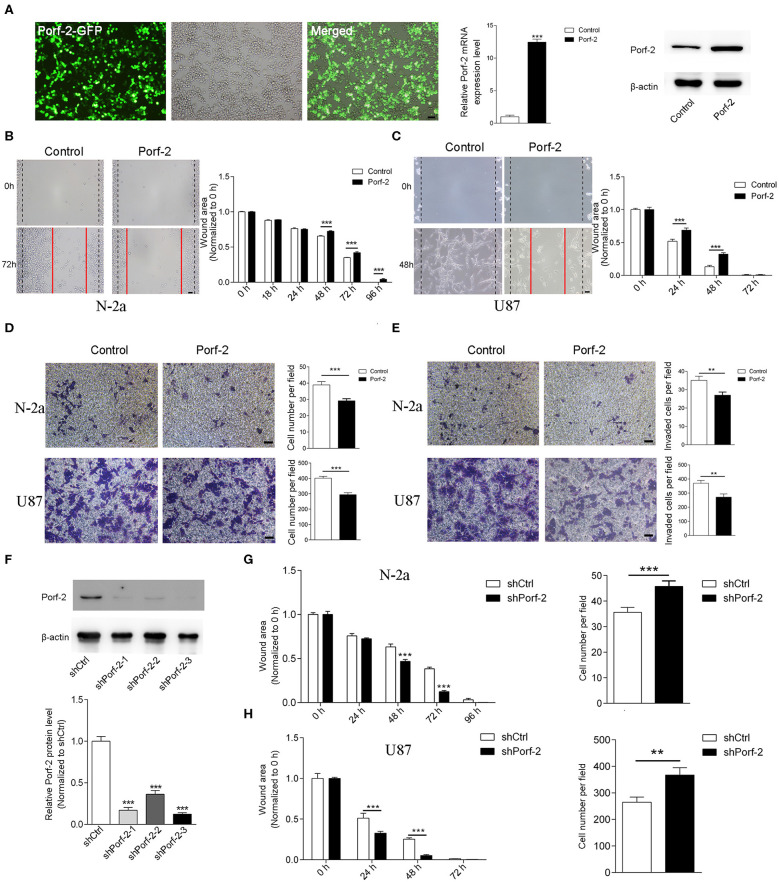
Porf-2 suppressed Neuro-2a cell migration. (A) The GFP image shows the overexpression of Porf-2 in N-2a cells. RT-PCR and western blotting confirmed the overexpression of Porf-2. β-actin was used as a loading control. Scale bar, 200 μm. (B) Representative images of the wound healing assay of N-2a cells at different time points in the control and Porf-2 group. The red lines indicate the wound area. Scale bar, 200 μm. Quantification of the wound area at the indicated time points in the control and Porf-2 group. (C) Representative images of the wound healing assay of U87 cells at different time points in the control and Porf-2 group. The red lines indicate the wound area. Scale bar, 200 μm. (D) Representative images of the N-2a and U87 cells that migrated to the lower chamber in the trans-well assay in control and Porf-2 group. Scale bar, 200 μm. Quantification of the migrated cells. (E) Representative images of the N-2a and U87 cells that invaded into the lower chamber. Scale bar, 200 μm. Quantification of the invaded cells in control and Porf-2 group. (F) Western blots showing Porf-2 knockdown with shRNAs. (G) Quantification of the wound area of N-2a cells at the indicated time points in the shCtrl and shPorf-2 groups. Quantification of migrated N-2a cells of the trans-well assay in the shCtrl and shPorf-2 groups. (H) Quantification of the wound area of U87 cells at the indicated time points in the shCtrl and shPorf-2 groups. Quantification of migrated U87 cells of the trans-well assay in the shCtrl and shPorf-2 groups. Error bars represent ± SEM; **P < 0.01, ***P < 0.001.